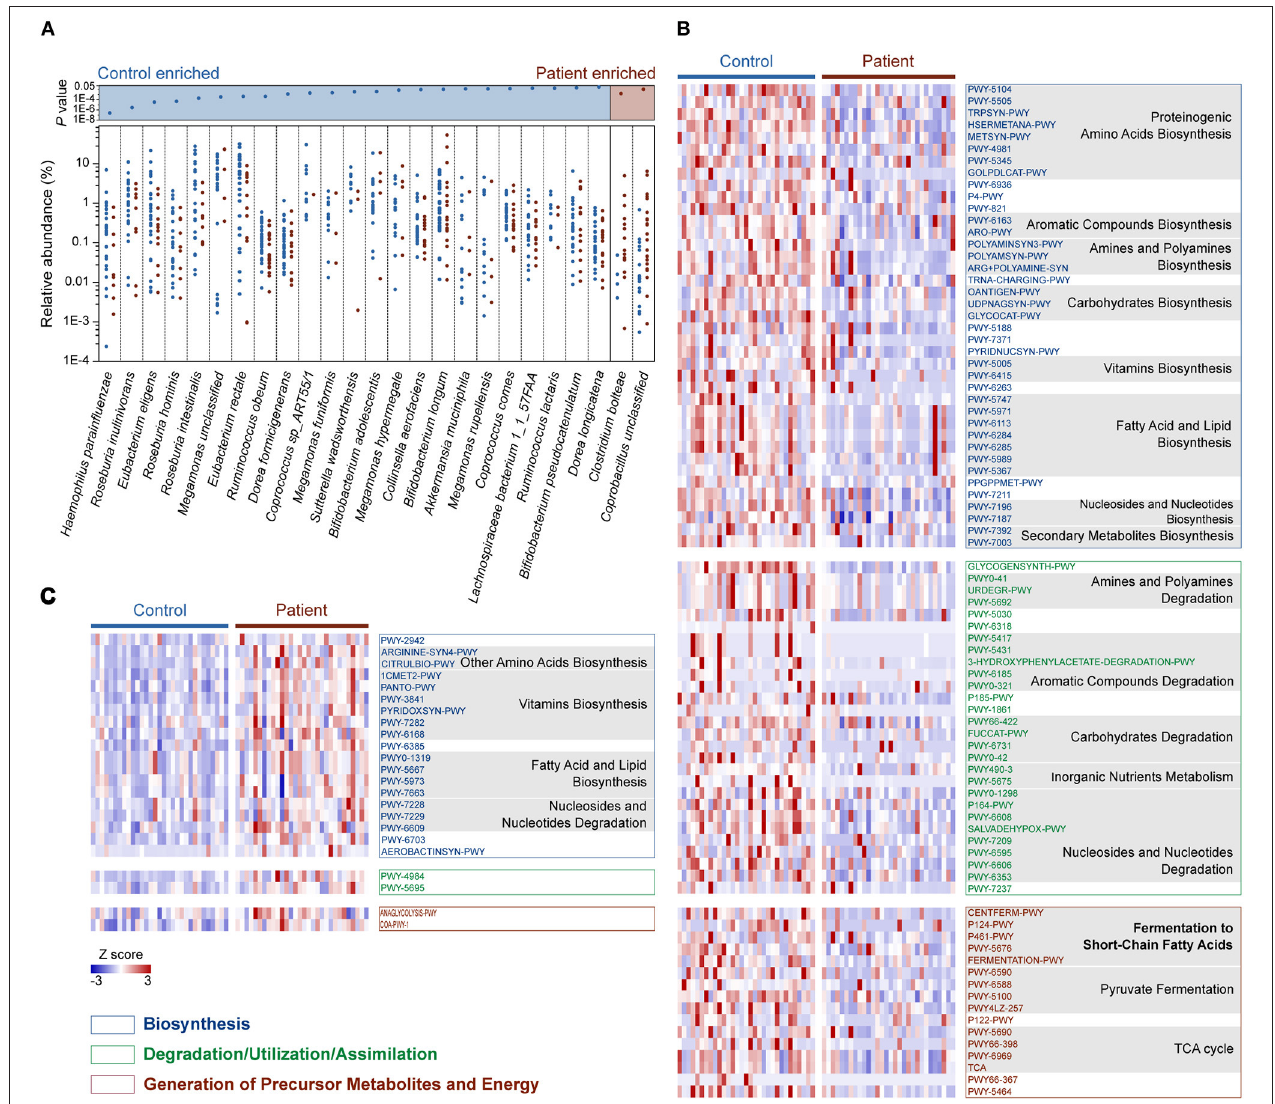
FIGURE 2 | Relative abundances of differentially enriched species and metabolic pathways in the gut microbiota of the C and P groups. (A) Differentially abundant species between the C and P groups. P -values for all differentially abundant species between groups are plotted above (Wilcoxon rank-sum test, FDR < 0.1, respectively). Species (present in at least 10% samples) with mean relative abundances of more than 0.001 were considered. (B) Heat map showing the control-enriched metabolic pathways and (C) the patient-enriched metabolic pathways. Among 110 differentially abundant pathways in the C and P groups (Wilcoxon rank sum test, FDR < 0.1), 106 belonging to Biosynthesis, Degradation/Utilization/Assimilation and Generation of Precursor Metabolites and Energy are shown. The pathways are ordered by consensus functional classification. The abundance of each pathway was converted to row Z